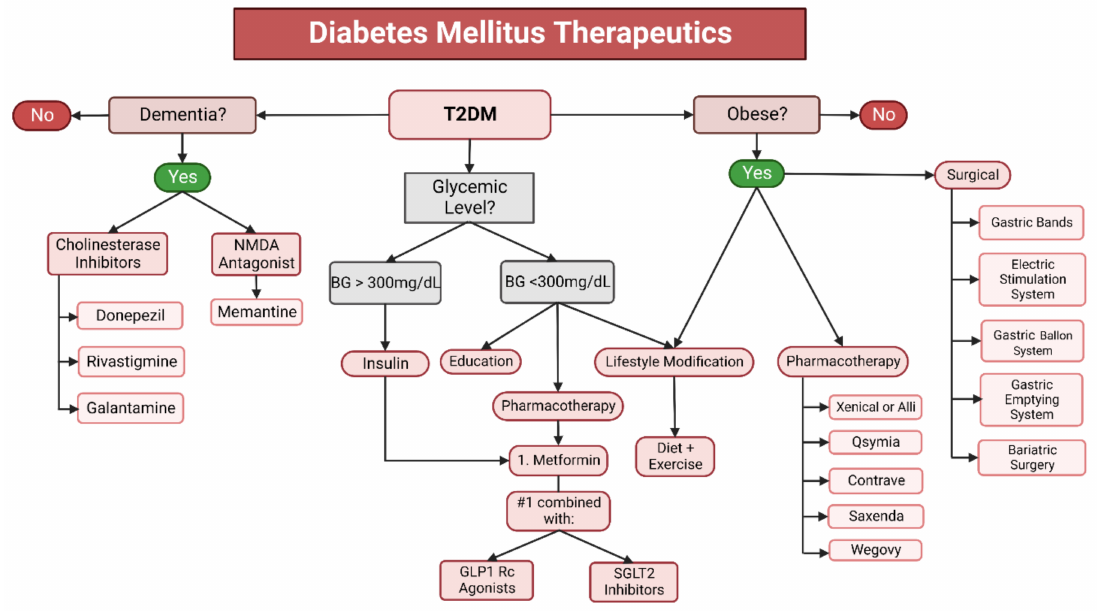
Figure 7. Similarities of the therapeutics for obesity, diabetes mellitus, and dementia . Because obesity, diabetes, and dementia are so closely related, several aspects of their treatments